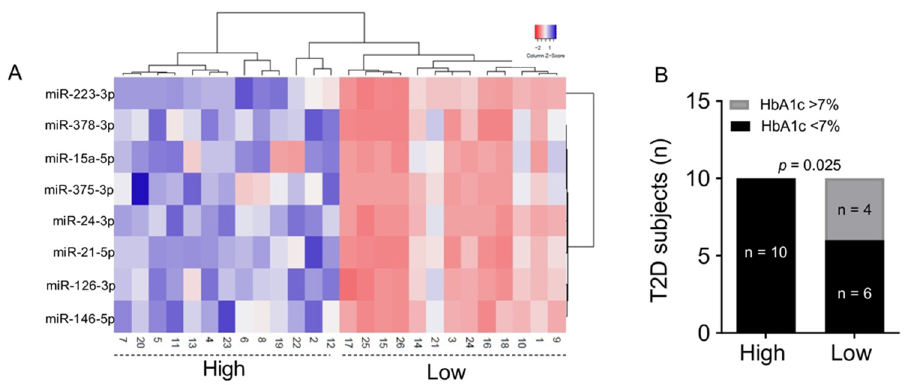
Figure 2. ( A ) Hierarchical clustering dendrogram analysis reporting expression values of each miRNA shown as ∆ Ct values and fitted into a color scale (blue: high expression; red: low/null expression) (model: Euclidean − Average linkage); miRNAs are reported in rows while T2D subjects (ID number) are reported in columns. ( B ) Proportion of patients achieving glycemic target in the high expression group and low expression group after 12 months of GLP1-RA therapy. Statistics using Chi-square.